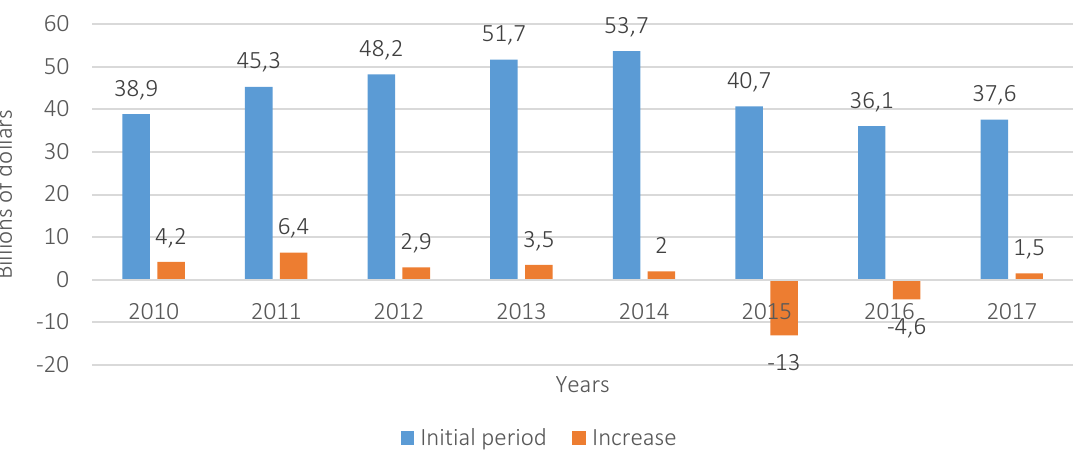
Figure 3. Dynamics of volume of direct foreign investments in the economy of Ukraine from January 1, 2010 to December 1,